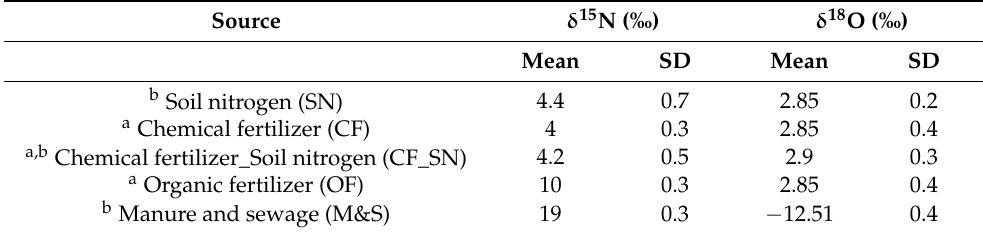
Table 3. The δ 15 N and δ 18 O values of various nitrate sources.